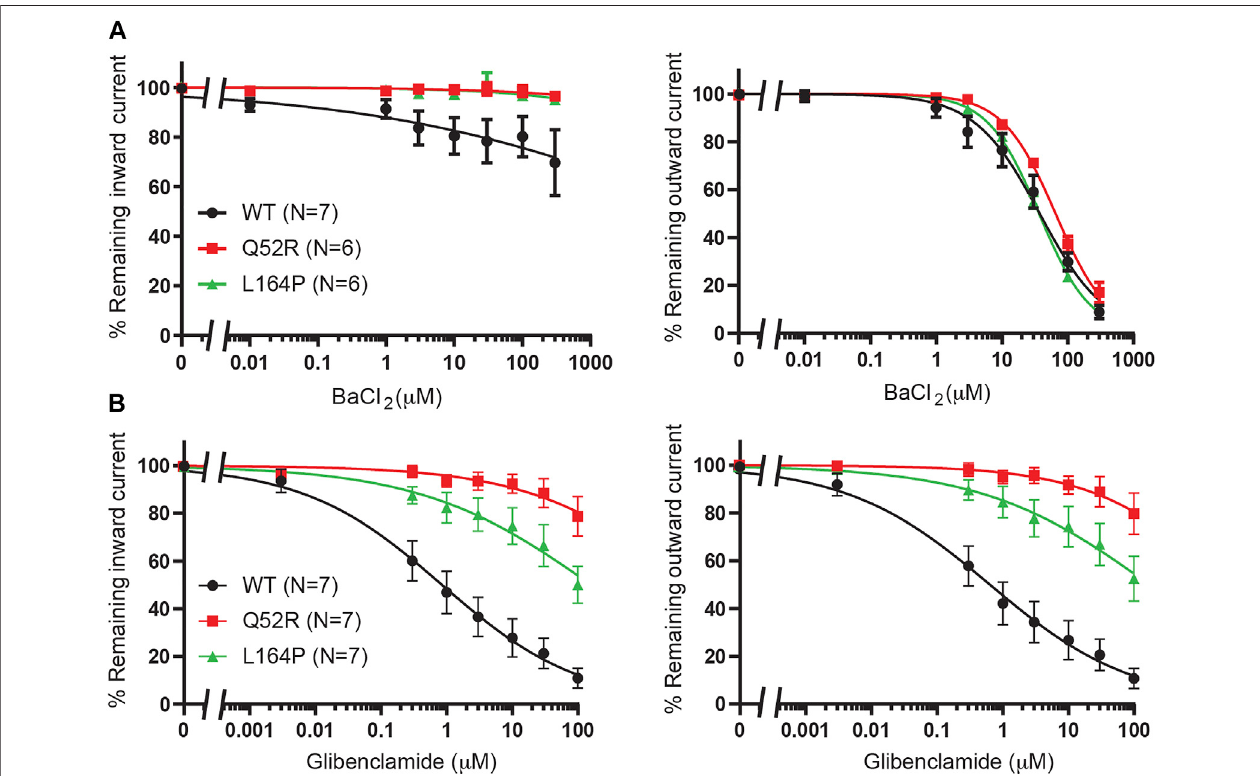
FIGURE 2 | Pharmacological validation of Q52R and L164P K IR 6.2 mutations. IC 50 curves of K IR 6.2/SUR2a inward (at − 80 mV), left panels, and outward (at +50 mV), right panels, current inhibition in response to increasing concentrations of (A) BaCl 2 and (B) glibenclamide. Wildtype K IR 6.2/SUR2a serves as control. Data were fi tted with Hill equation to estimate the IC 50 values. Data are shown as mean ± SEM. N depicts number of measurements on independent inside-out